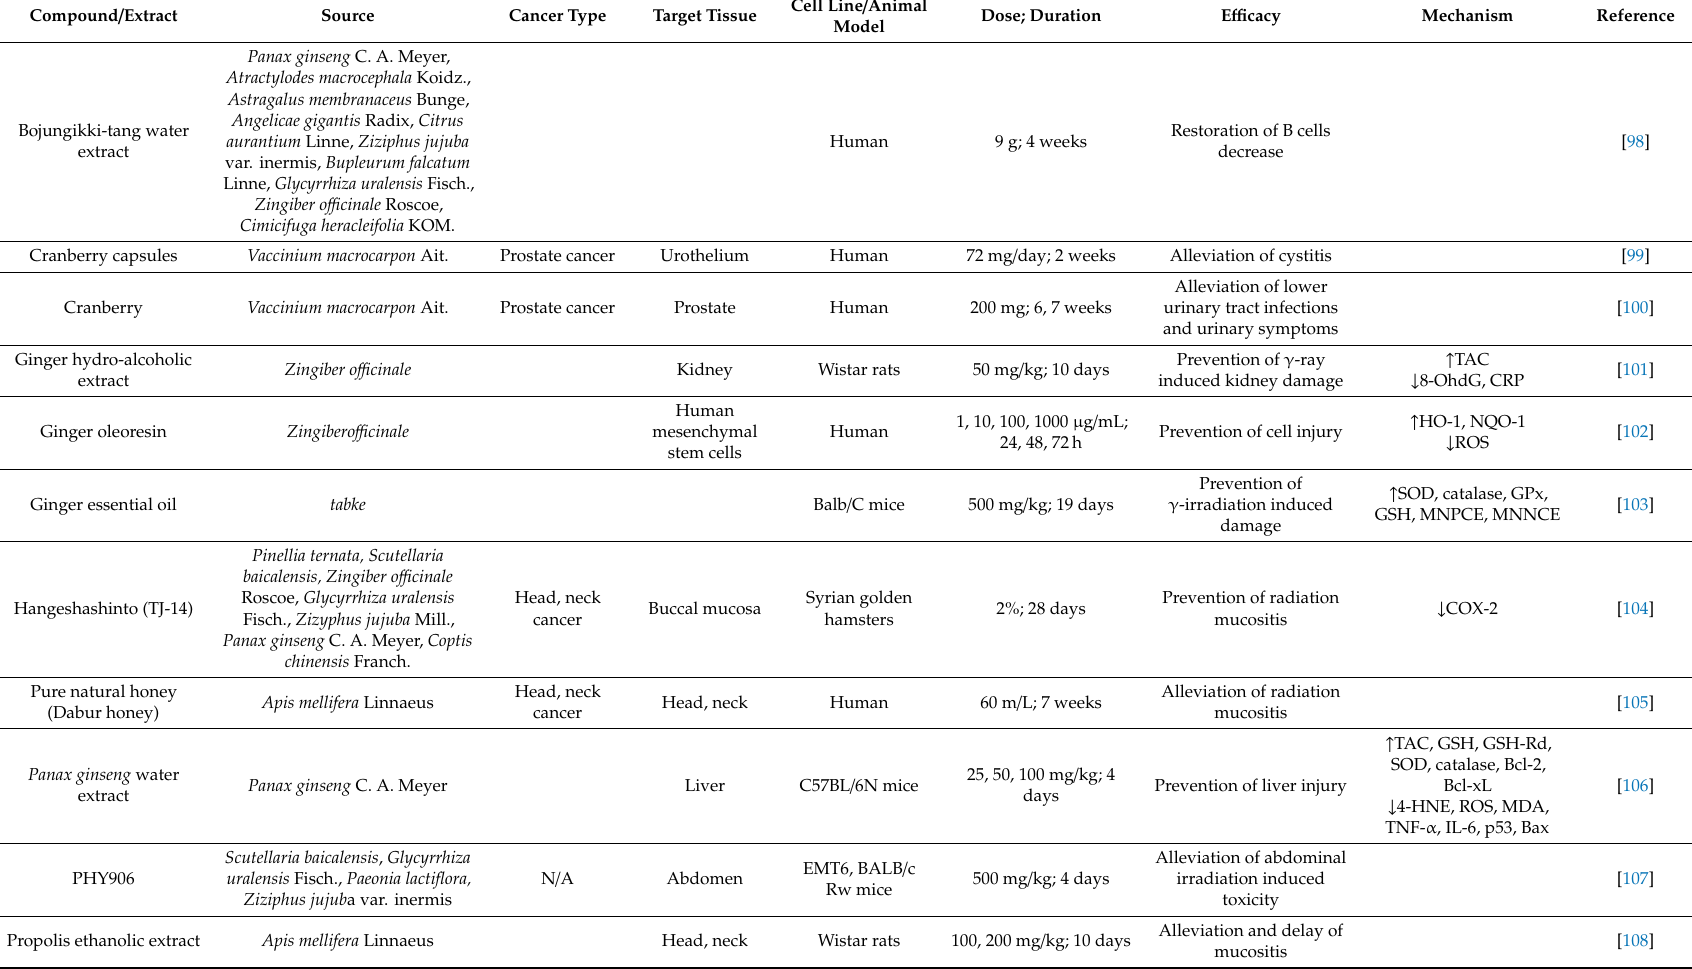
Table 3. Plant-derived drugs and sequela of